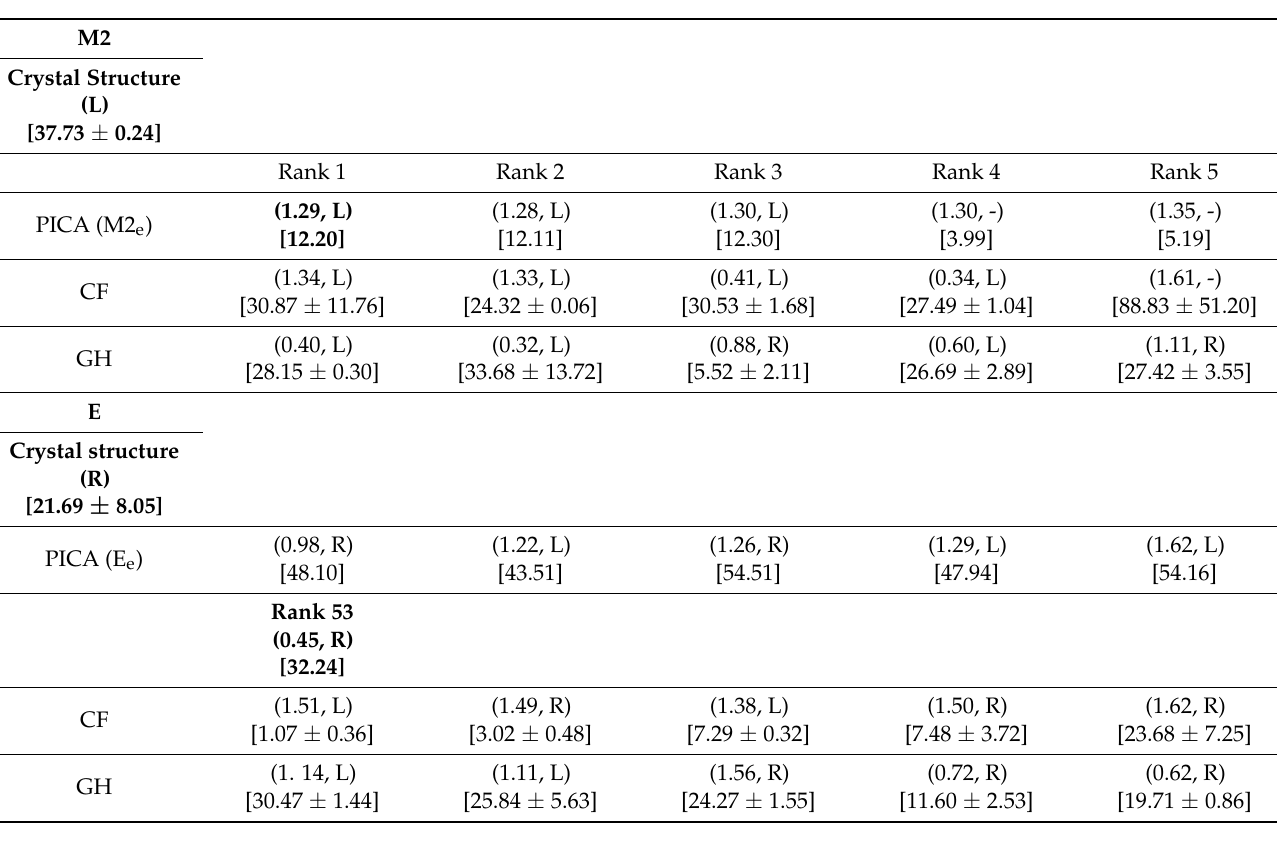
Table 2. Comparative ranking of the oligomeric structures based on the estimated binding energy of M2 and E protein, M2 e and E e , in case of PICA, using PICA, ColabFold (CF) and GalaxyHomomer (GH) with experimental structures of M2 (PDB ID: 1NYJ) and E protein (PDB ID: 5X29). For PICA all atom (AA) models of M2 e and E e are used using the same amino acid sequence as for M2 i and E p , respectively. For all other server’s amino acid sequences, M2 i and E p are used. The numbers in brackets represent the root mean square deviation (RMSD) values in nm of the structures with reference to the experimental structures. Letters R and L refer to right- and left-handed bundles of the crystal structures. Numbers in squared brackets represent the tilt angles ( ◦ ), given as average with standard deviation for M2 e and E e proteins. “-” = straight TMDs; no handedness. The subscripts indicate the use of: i = ideal helix used; e = sequence as in experimental study reported in literature or experimental structure used for which PDB ID is available; p = ideal structures from sequences of amino acids predicted to form a helical TMD. The best models of PICA compared with the experimental structure are shown in